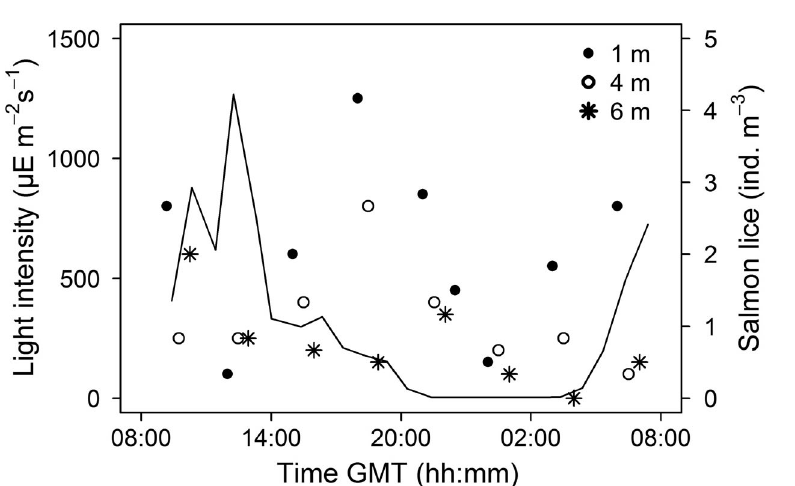
Fig. 4. Light intensity above the water column (line) and density of Lep- eophtheirus salmonis at 3 different depths at the center of a salmon net cage during a 24 h measuring period from 6 to 7 May